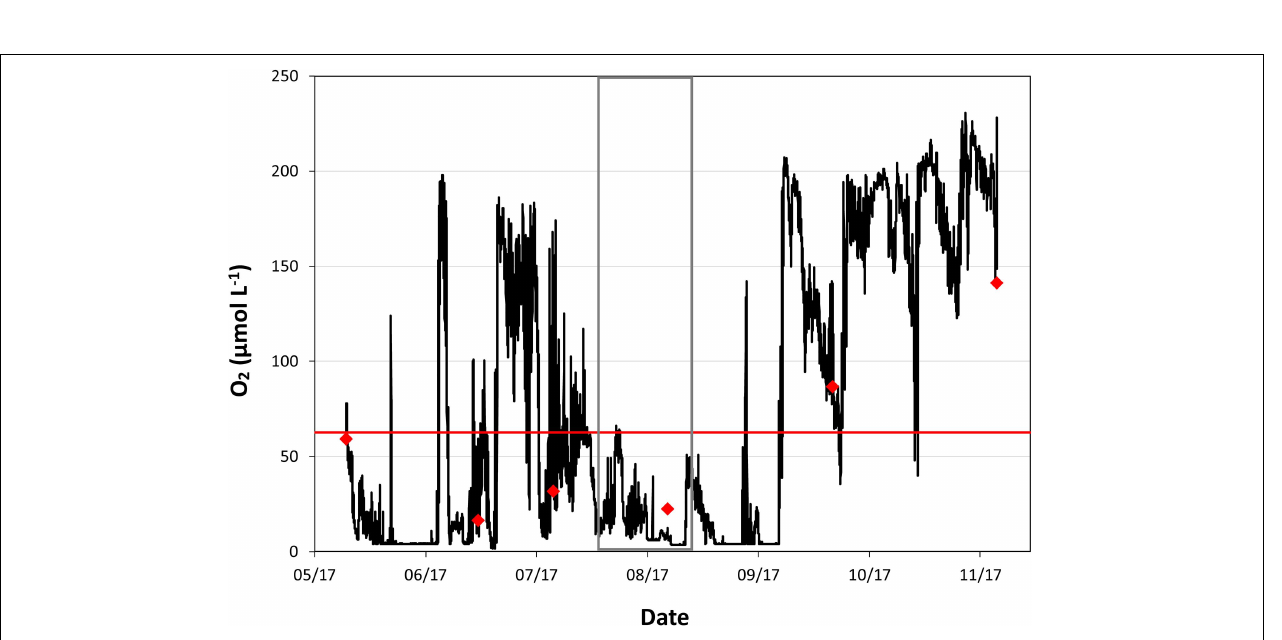
FIGURE 3 | Time series of dissolved oxygen concentration in bottom water ( µ mol L − 1 ) at Station C6C (O2 on Figure 1 ) showing substantial variability linked to tropical storms (Cindy on June 21st 2017) and subsequent water column mixing followed by rapid de-oxygenation at the beginning of July 2017 and later. The red